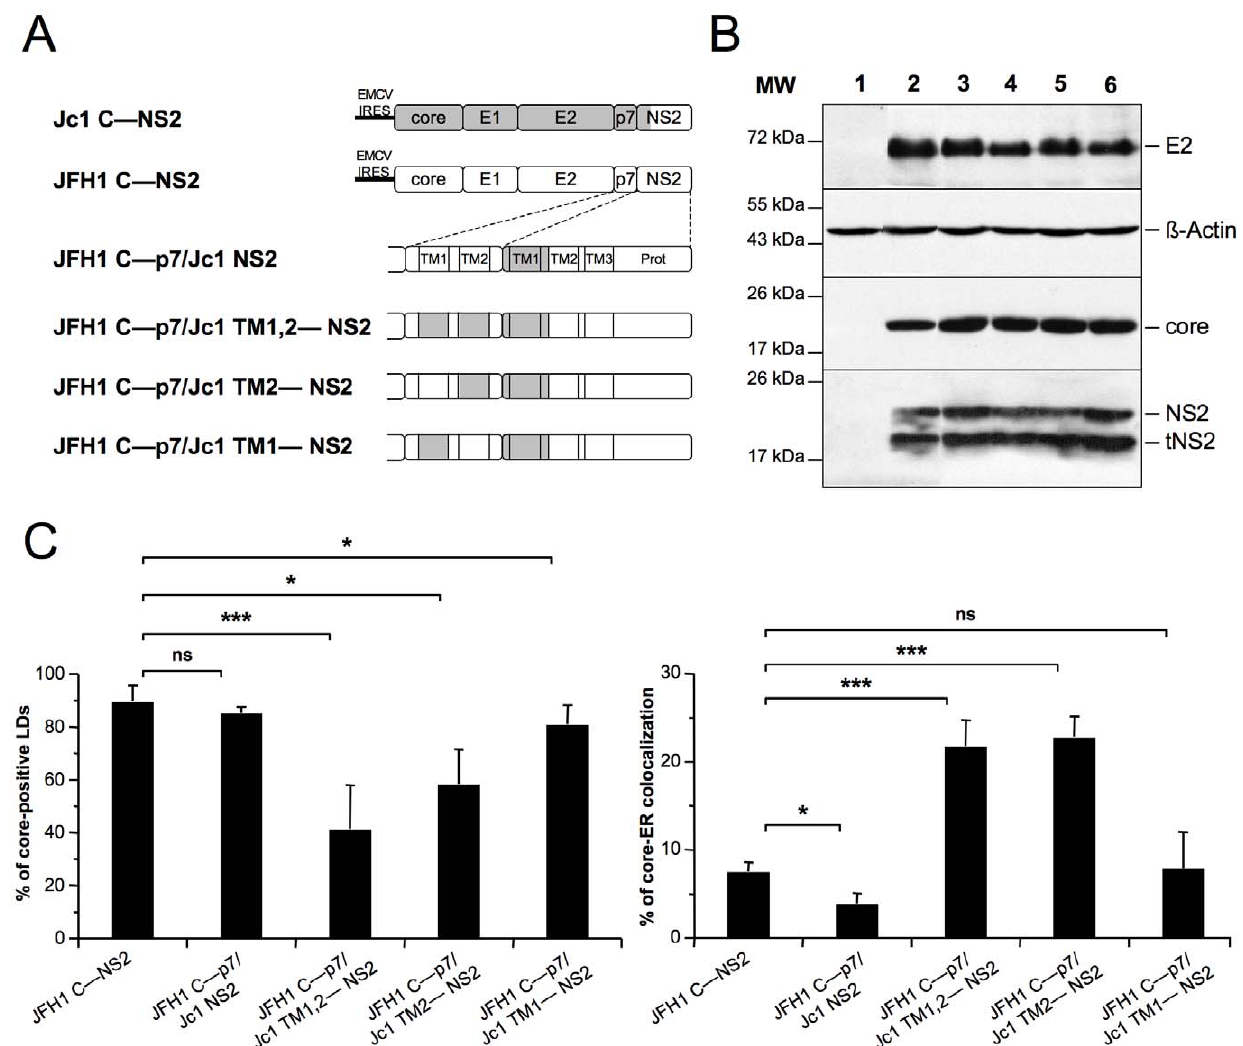
Figure 7. p7 and NS2 trans-membrane compatibility modulates intracellular localization of core. Huh7.5 cells were transfected with plasmids expressing core-E1-E2-p7-NS2 (C—NS2) polyproteins from JFH1 (white boxes) and J6-CF (Jc1) (gray boxes) HCV sequences in which the trans-membrane segments (TM1 and/or TM2) of p7 and/or NS2 were swapped, individually or in combination, as indicated ( A ) Prot, NS2 protease domain. At 72 h post-transfection, lysates from mock-transfected cells (lane 1) or from cells transfected with the JFH1 C—NS2 (lane 2), JFH1 C—p7/ Jc1 NS2 (lane 3), JFH1 C—p7/Jc1 TM1,2—NS2 (lane 4), JFH1 C—p7/Jc1 TM2—NS2 (lane 5) and JFH1 C—p7/Jc1 TM1—NS2 (lane 6) expression constructs were prepared and examined by Western blot analysis using antibodies against NS2, core and E2 proteins ( B ). The input of the